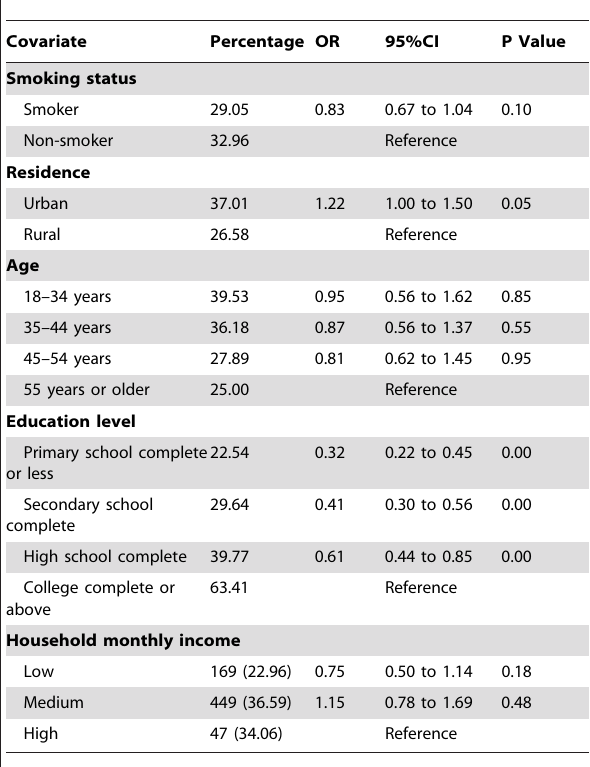
Table 2. Factors associated with tobacco